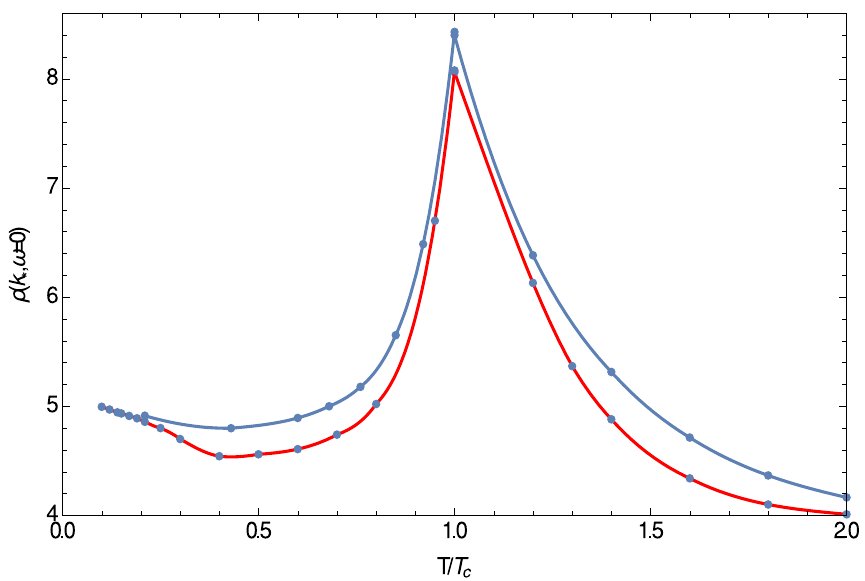
Figure 17. The value of (cid:26) ( k (cid:3) ; ! =0) is shown as a function of T=T c . The blue curve corresponds p to (cid:21) = 1 = (8 2), while the red curve corresponds to (cid:21) = 0 : 4.